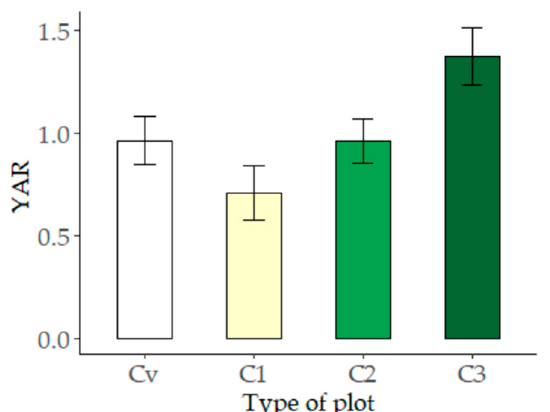
Figure 5. Mean yield achievement ratio (YAR) in plots in conventional production (Cv) and in their first, second or third year of conversion to organic farming (C1 to C3). Mean ± standard deviation.